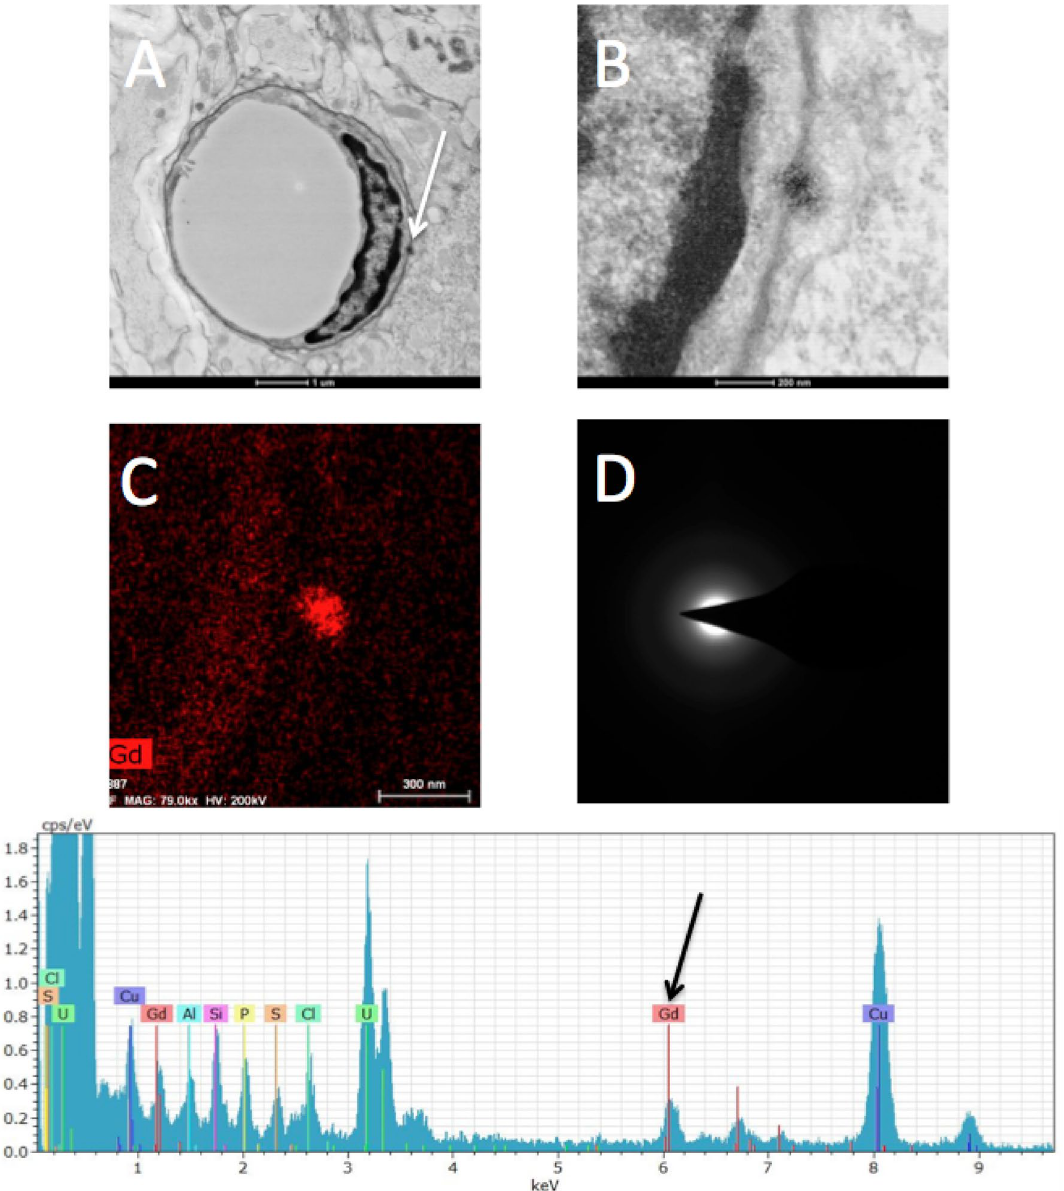
Figure 3. Localization of gadolinium after repeated gadodiamide administration. Most gadolinium observed in the DCN is in perivascular foci (n = 3 per group). Representative TEM with EDS of the DCN 1-year post dosing in a rat treated with 12 mmol/kg gadodiamide over 5 weeks. ( A ) low-magnification (×14,000) TEM image of a capillary with an electron dense focus indicated by white arrow. ( B ) high-magnification (×79,000) TEM image of the same focus. ( C ) High magnification TEM image filtered to show potential gadolinium-positive foci. ( D ) Diffraction image from an electron dense focus showing no diffraction—this implies an amorphous, non-crystalline structure. Bottom—spectrum obtained from the center of the focus shown in ( A – C ) above. A definitive gadolinium spectrum is